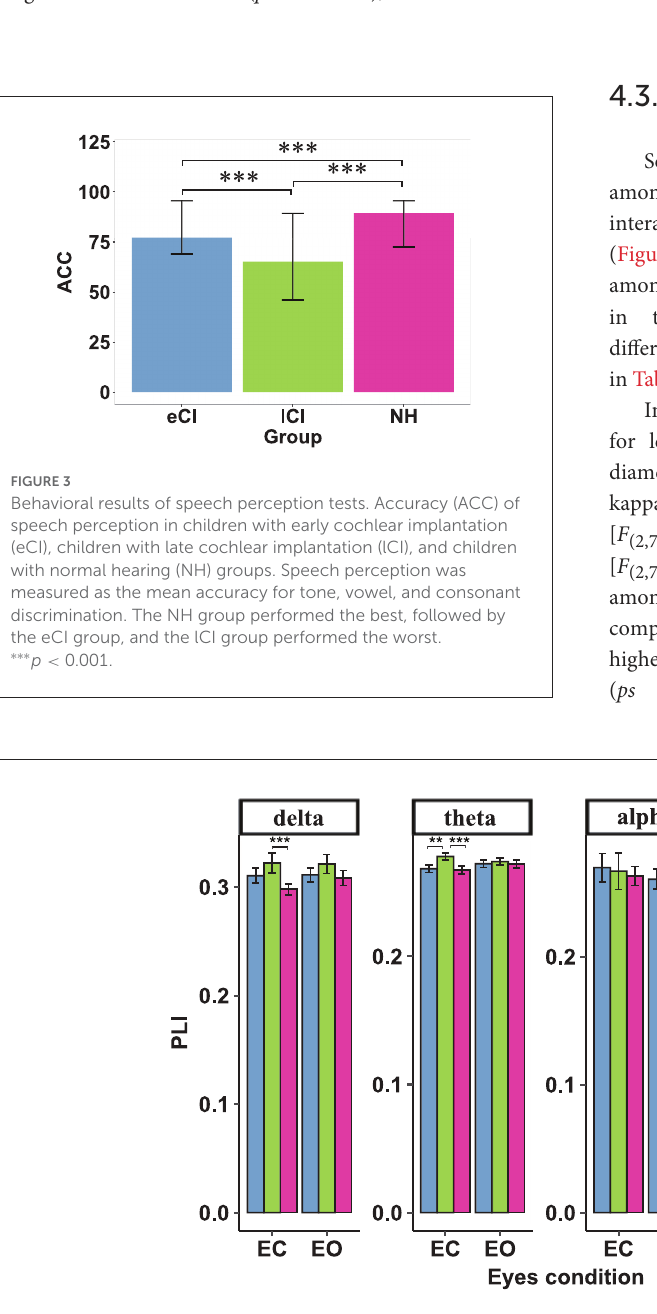
FIGURE4 Functional connectivity between the left temporal region and left occipital region. The average functional connectivity between the left temporal region and left occipital region was defined by the phase lag index (PLI) (y-axis) under the eyes-closed (EC) and eyes-open (EO) conditions (x-axis) in the delta, theta, alpha, and beta frequency bands (top) in children with early cochlear implantation (eCI), children with late cochlear implantation (lCI), and children with normal hearing (NH). Interactions of eyes condition and group were found in delta and theta bands. In the delta band, lCI had higher PLI values than NH group, and in the theta band, lCI had higher PLI values than either eCI or NH children. ∗∗ p < 0.01 and ∗∗∗ p <